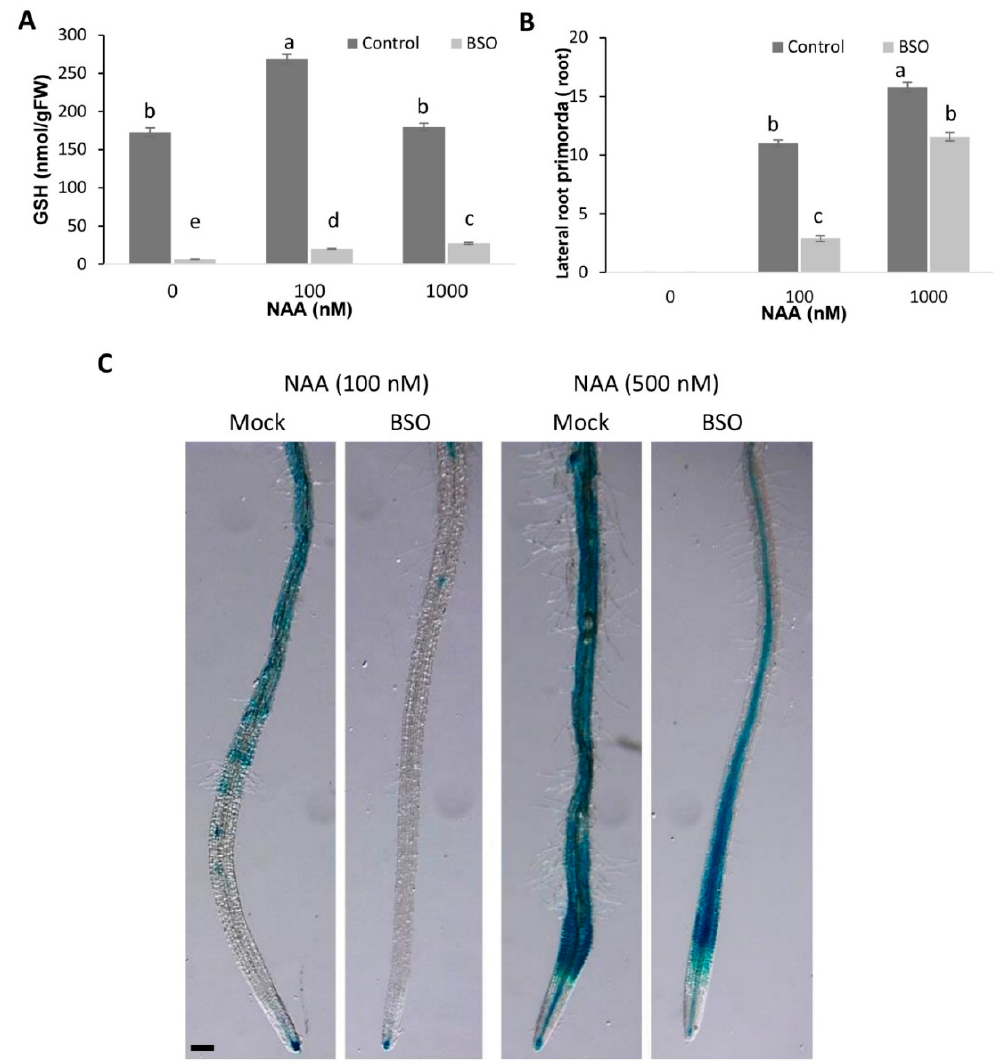
Figure 8. GSH affected the induction of lateral root primordia and the DR5 signal in isolated roots. ( A ) The effect of 1 mM L-buthionine-(R,S)-sulfoximine (BSO) and different NAA concentrations on GSH concentrations in isolated roots. Error bars represent the means ± SEs ( n = 3); ( B ) BSO inhibited de novo formation of the lateral root primordia. Error bars represent the means ± SEs ( n = 10). Different letters indicate a significant difference at p < 0.05. Fisher’s protected LSD test was used to compare the individual means; ( C ) BSO inhibited the auxin response, determined as DR5 activity, after NAA treatments. Scale bar − 100 µm.